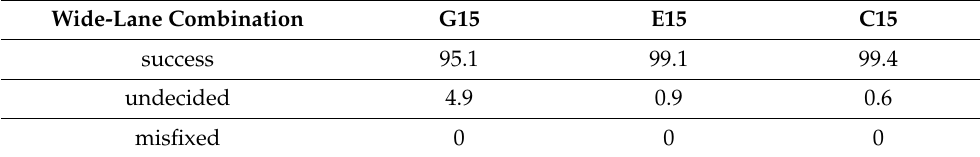
Table 8. Fixing rate of the single-epoch ambiguity resolution of three wide-lane combinations (%). Wide-Lane Combination